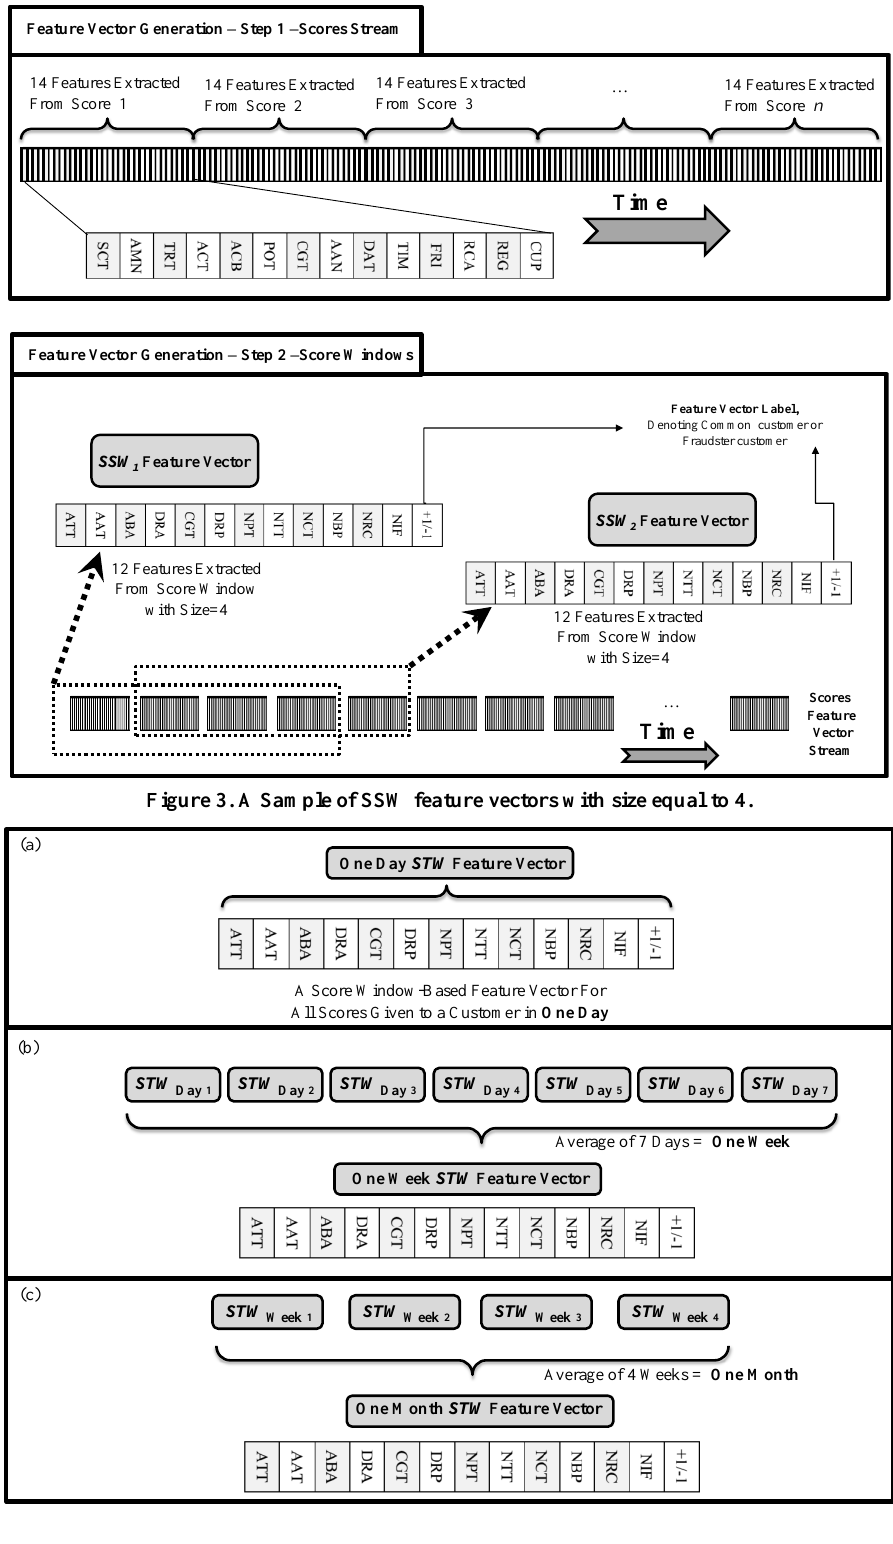
Figure 4. Samples of one-day STW (a), one-week STW (b), and one-month STW (c) feature